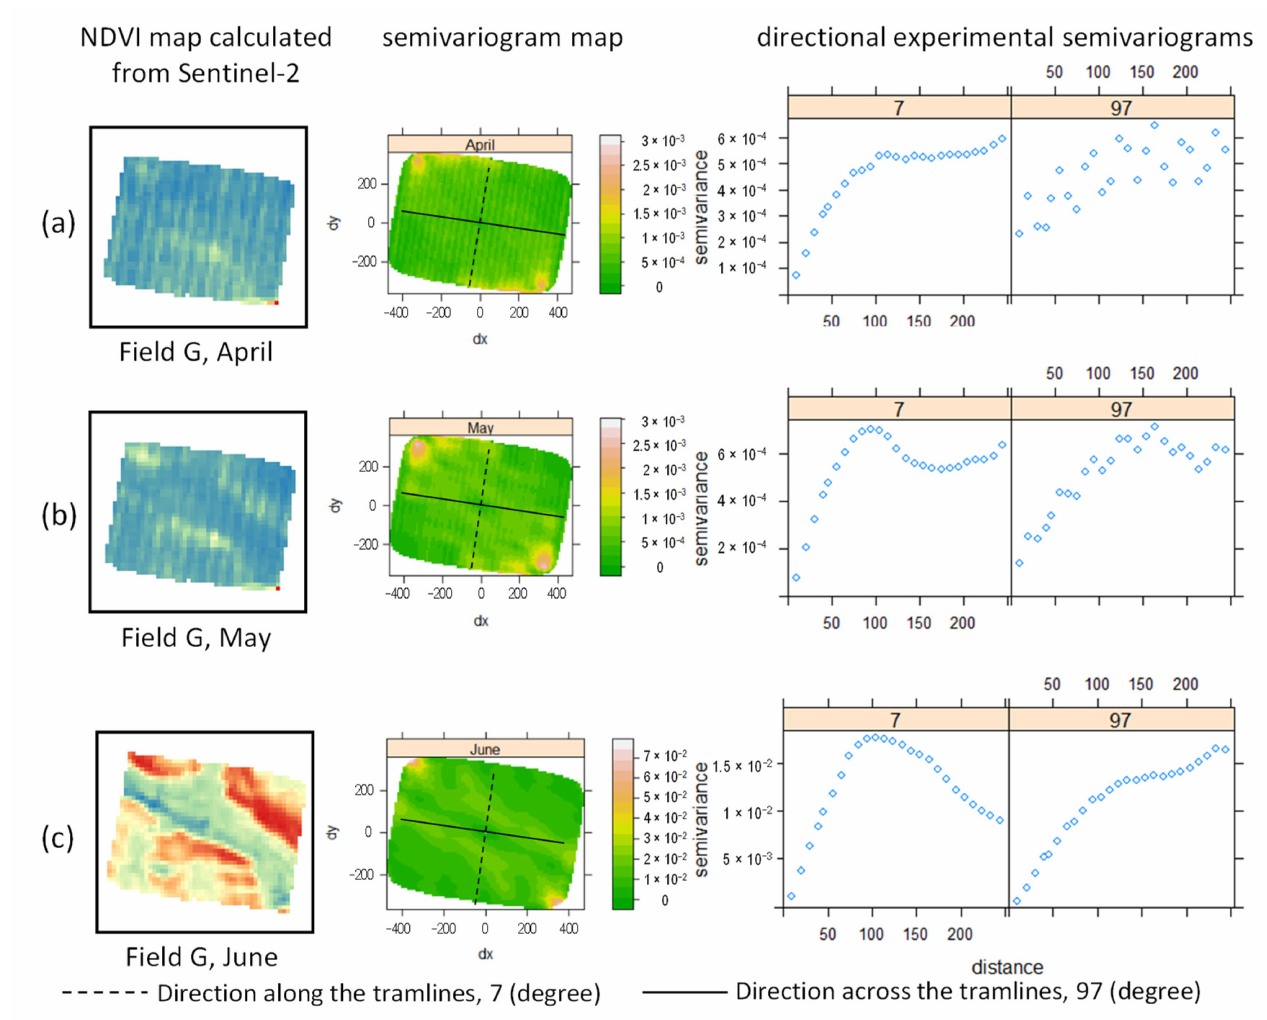
Figure 10. Relationship between the semivariogram map and directional experimental semivari- ograms calculated along and across the tramline direction for ( a ) April, ( b ) May, and ( c ) June for field A. From left to right, it shows the NDVI image, the semivariogram map calculated from Sentinel-2 NDVI and profiles of directional experimental semivariograms along and across the tramlines. The dashed and continuous line in the semivariogram maps indicate the direction of the along and across tramline directional